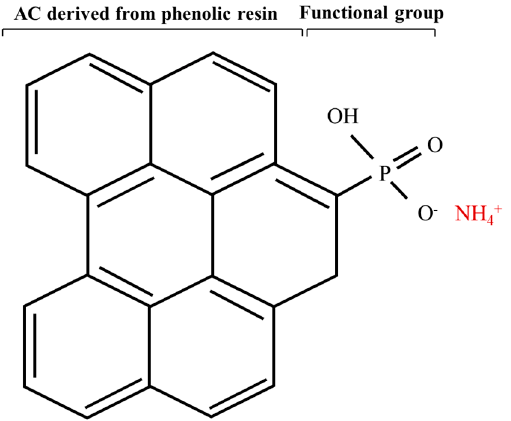
Figure 5. Structural schematic of the phosphate-functionalized activated carbon, which formed a complex with ammonium.